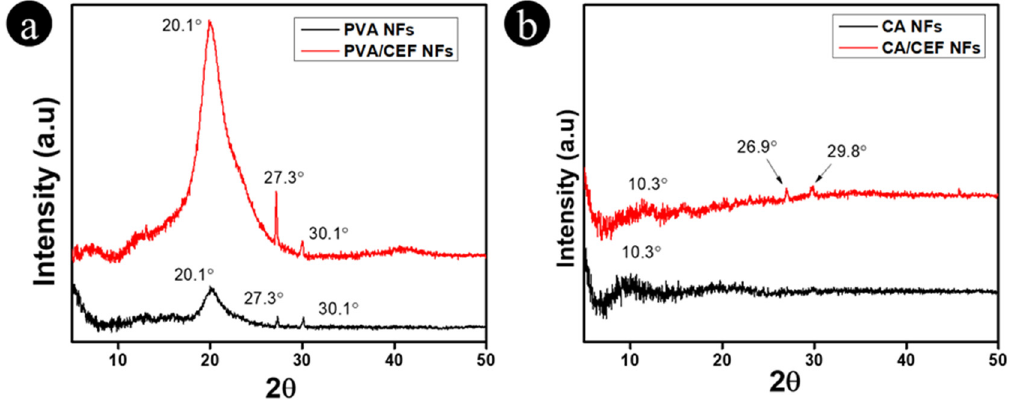
Figure 3. XRDspectra of nanofibers: ( a ) PVA and PVA/CEF NFs and ( b ) CA and CA/CEF NFs.